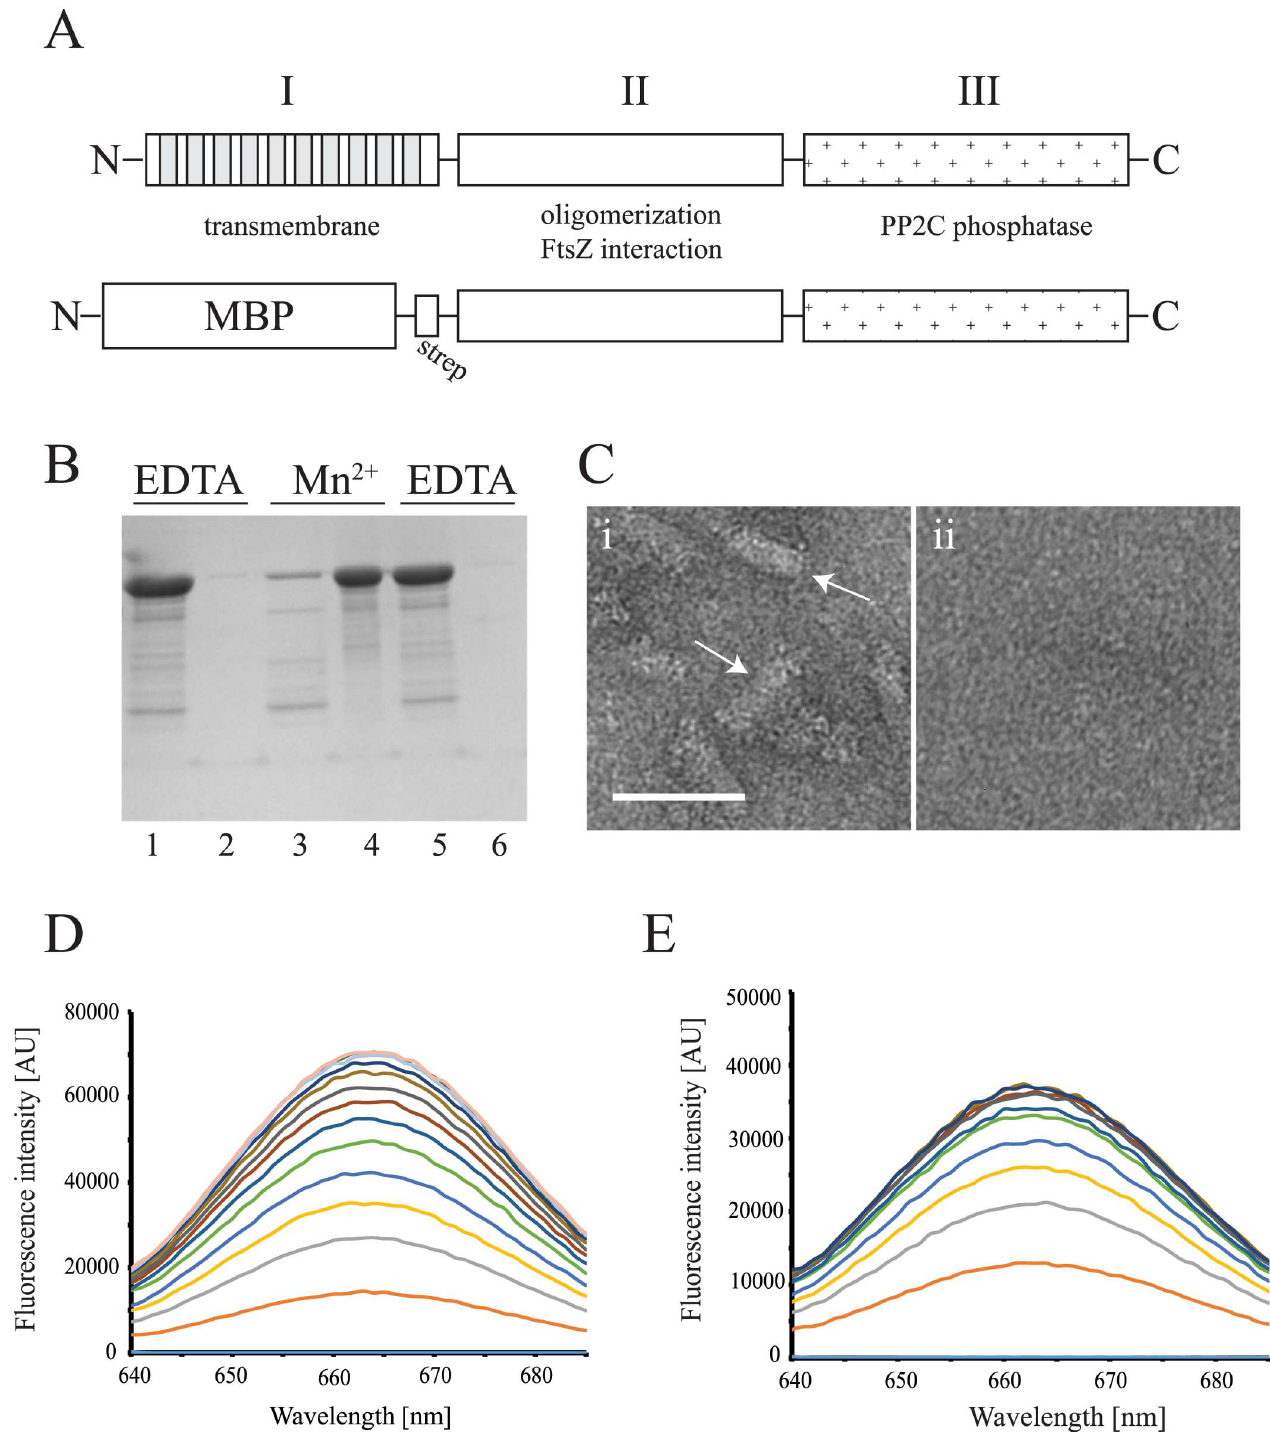
Fig 1. (A) The putative three domainstructure of SpoIIE (top) and a schematic of the SpoIIE construct used in this study (bottom), (B) SDS-PAGE of the sedimentation of ms-SpoIIE cyt . Ms-SpoIIE cyt was pre-incubated with 1 mM EDTA (lanes 1 and 2), followedby the incubation with 5 mM MnCl 2 (lanes 3 and 4), followedby the incubationwith 10 mM EDTA (lanes 5 and 6). Odd numbersbelow the image represent supernatant fractions and even numbers representpellet fractions, (C) Electron microscopy of ms-SpoIIE cyt oligomersafter co-purification with Fe 2+ (i). Oligomers were not observedafter incubation of the protein with 5 mM EDTA (ii). Arrows point to rod and circular structures of ms-SpoIIE cyt . Scale bar: 50 nm, (D, E) Fluorescence emissionspectra of s-SpoIIE cyt -Cy5 titrated into a buffer in the absence(D) and presence(E) of Mn 2+ .